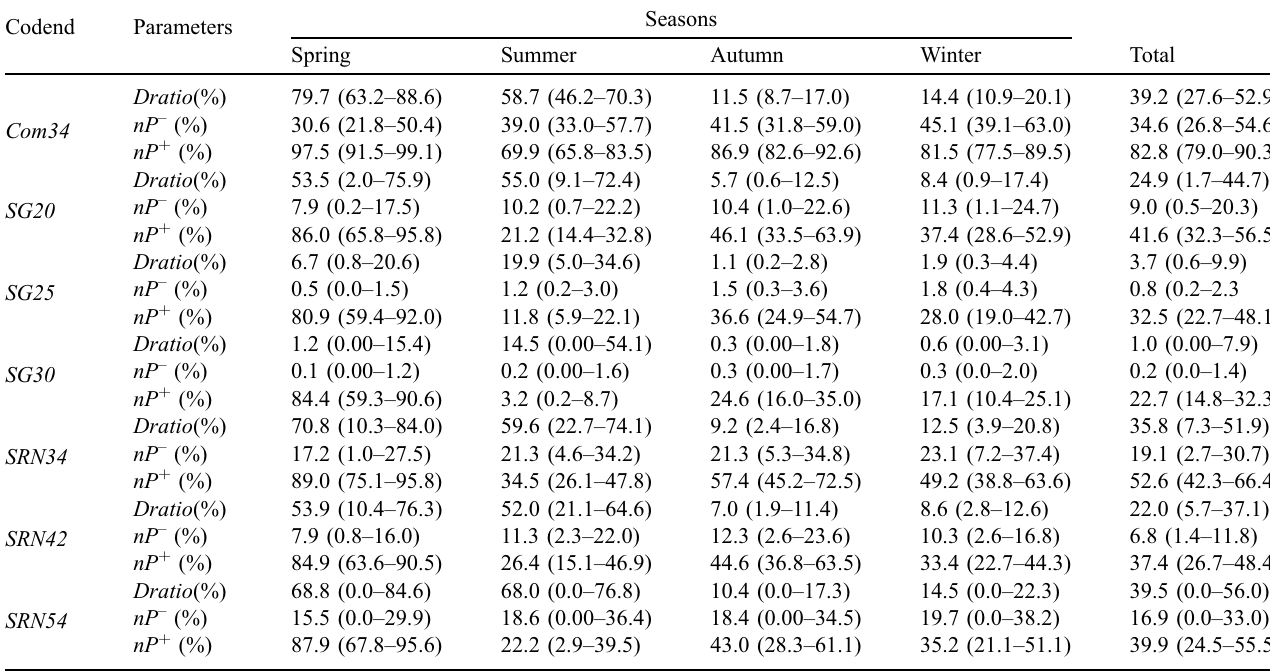
Table 5. Fishing ef fi ciency indicators. Fishing percentage of retained specimens below ( nP (cid:2) ) and above ( nP þ ) the speci fi c MLS (10cm) and